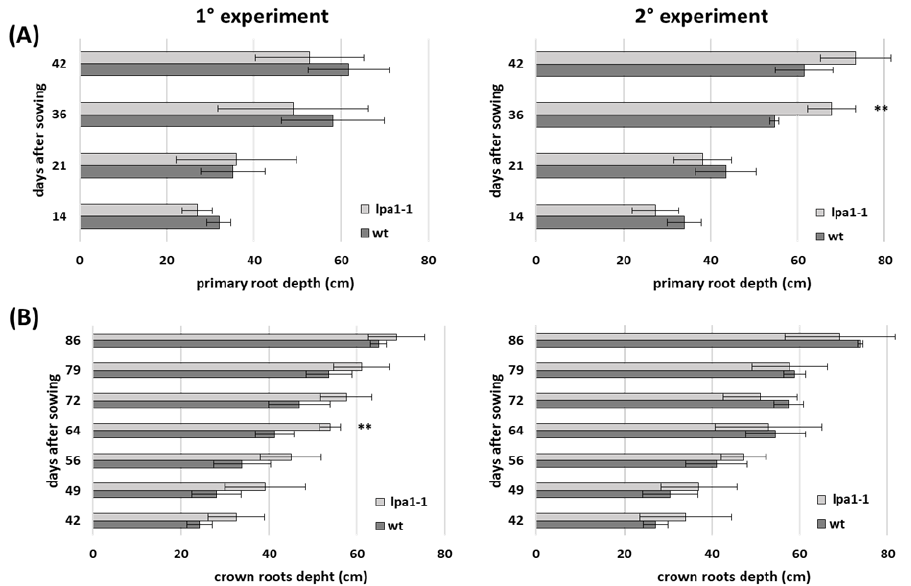
Figure 6. Depth of the embryonic primary root ( A ) and of the post-embryonic crown roots ( B ) meas- ured every week till flowering. The data represent the means of three biological replicates in two different experiments. Significant differences between wild-type and lpa1-1 were assessed by Stu- dent’ s t -test (** p < 0.05).